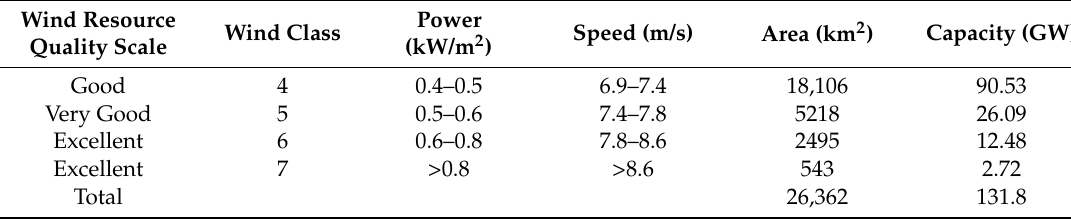
Table 11. Wind resource in Pakistan at 50 m from good to excellent.